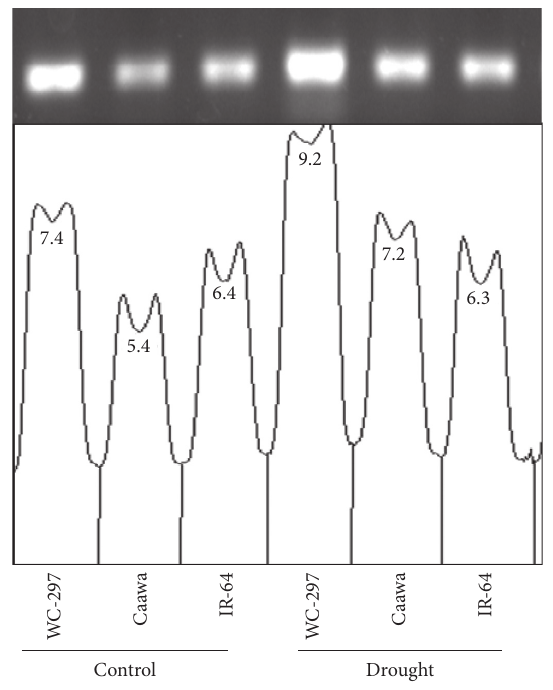
Figure 4: Drought-induced change in the expression of OsP5CS . A significant change in the expression of OsP5CS was recorded for drought tolerant (WC-297), moderately drought tolerant (Caawa), and drought susceptible (IR-64)